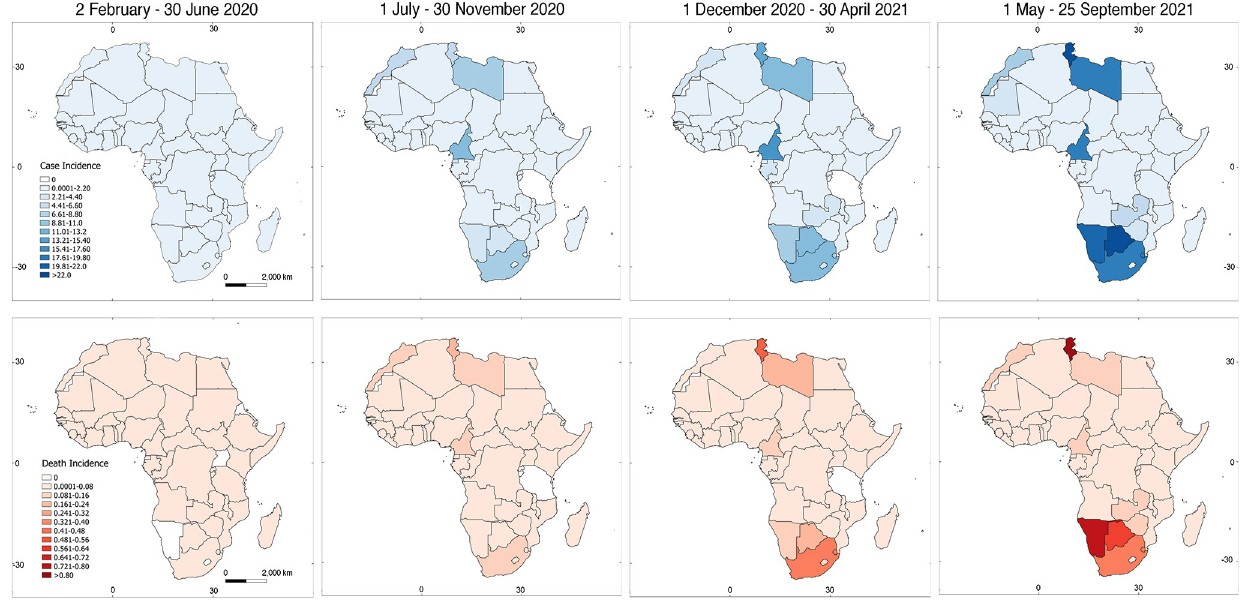
Fig 2. Average case and death incidences of COVID-19 per 100,000 people over four five-month time periods in Africa. Eight plots show average case incidences (upper panels) and average death incidences (bottom panels) over four five-month time periods from 2 February 2020 to 25 September 2021. Scale is the same for all case/death incidence maps and is depicted in the left panels; numbers are individuals affected per 100,000